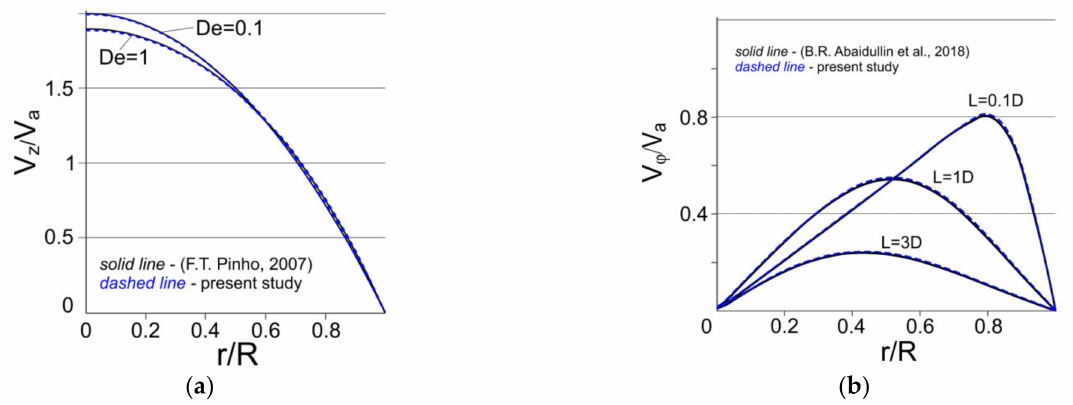
Figure 4. Comparison with literature data: ( a ) steady viscoelastic flow in a pipe [42], ( b ) swirl decay in a pipe (water, K = 1, Re = 98.8)